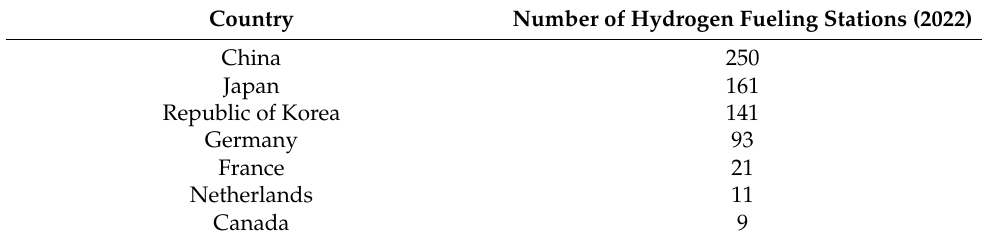
Table 2. Number of hydrogen fueling stations in different countries